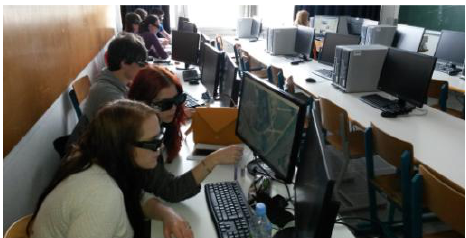
Figure 2: Students running practical exercises in computer